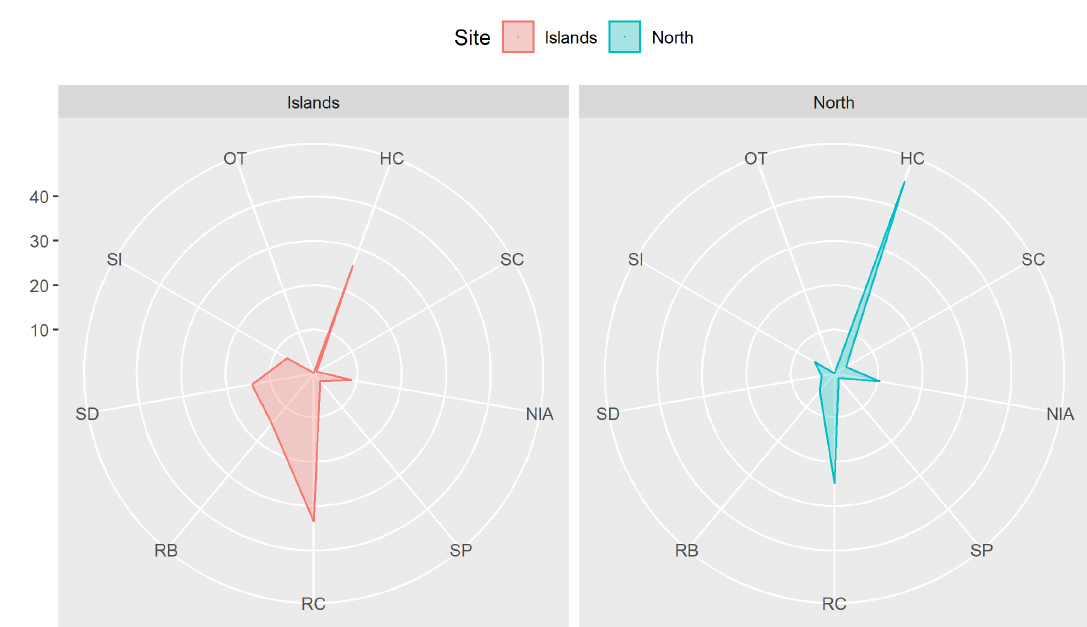
Figure 2. Radar plot giving an overview of benthic cover distribution on the coral reef sites on the Palk Bay islands ( left ) in comparison with those on the northern coast of the Jaffna Peninsula ( right ). (HC- hard coral, SC- soft coral, NIA- dead coral with macroalgae or nutrient indicating algae, SP- sponge, RB- coral rubble, RC- hard substrate of dead coral more than one year old covered by turf algae or encrusting coralline algae, SD- sand, SI- silt, and OT- others (including sea anemones, tunicates, gorgonians, or non-living